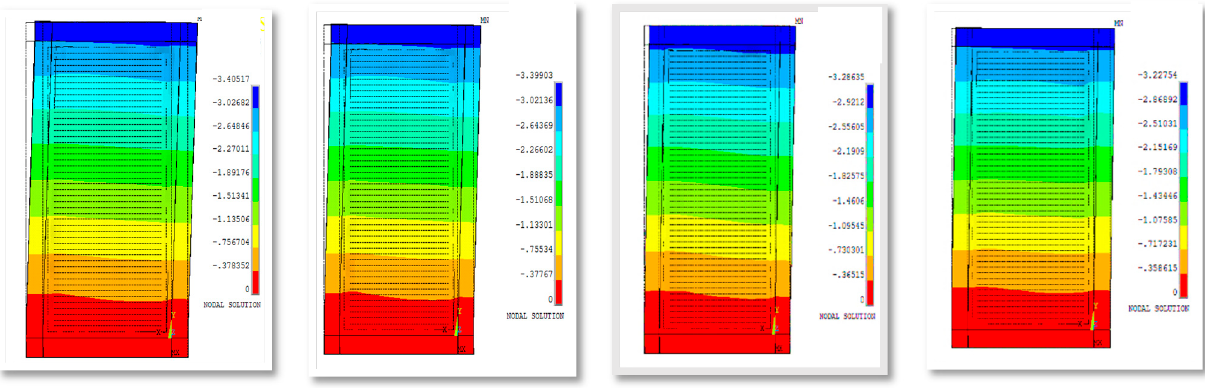
Figure 19. Lateral displacement of group 3.